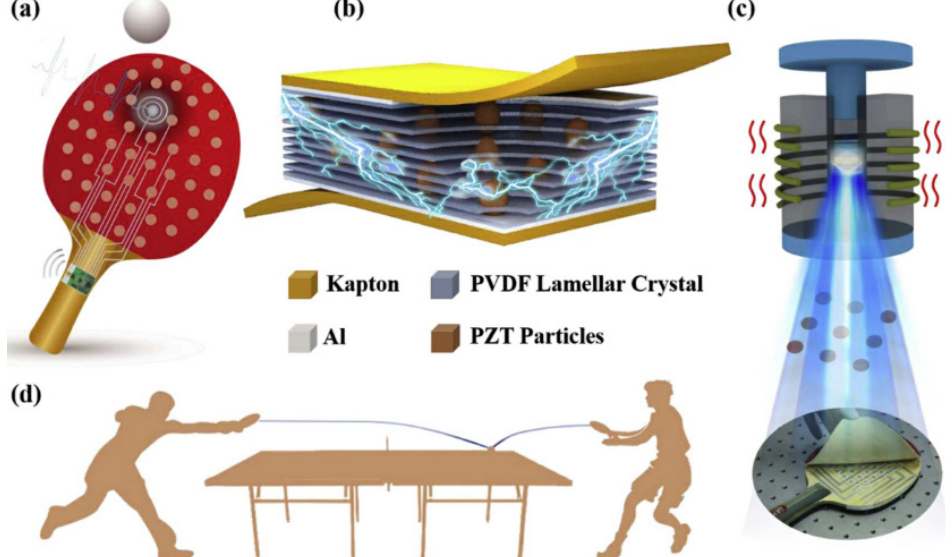
Figure 5. Schematic of the intelligent training system [48]. ( a ) Schematic of the intelligent rackets for table tennis monitoring. ( b ) The overall diagram and the detailed structure of the sensor. ( c ) The piezoelectric composite material of the intelligent racket and the production process of optical photos. ( d ) The application of the intelligent table tennis racket. Reproduced with the permission from reference [48].